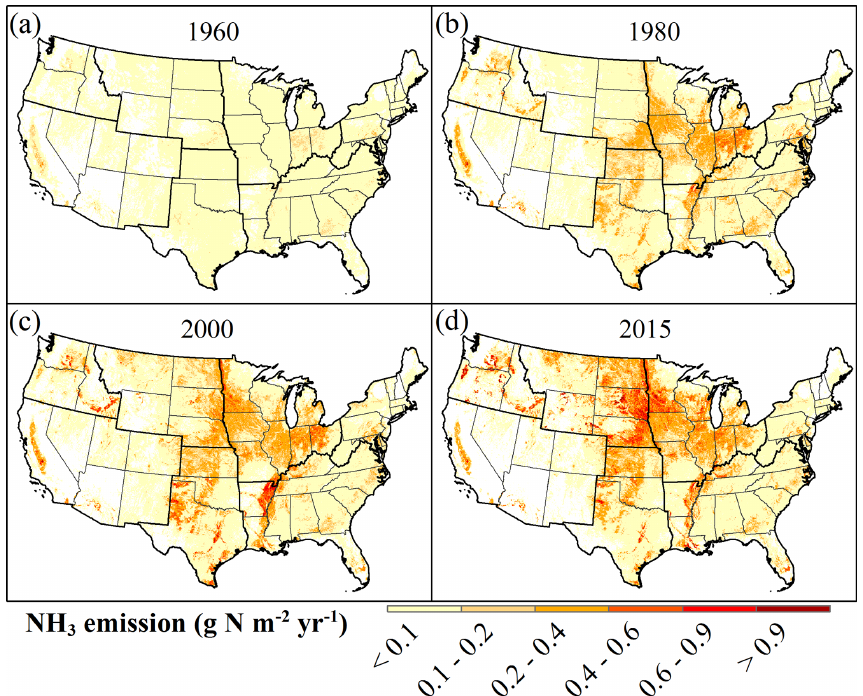
Figure 3. Spatial distribution of NH 3 emissions in the US from 1960 to 2015. Values represent NH 3 emission from synthetic N fertilizer applied over all crops in each 5km by 5km grid